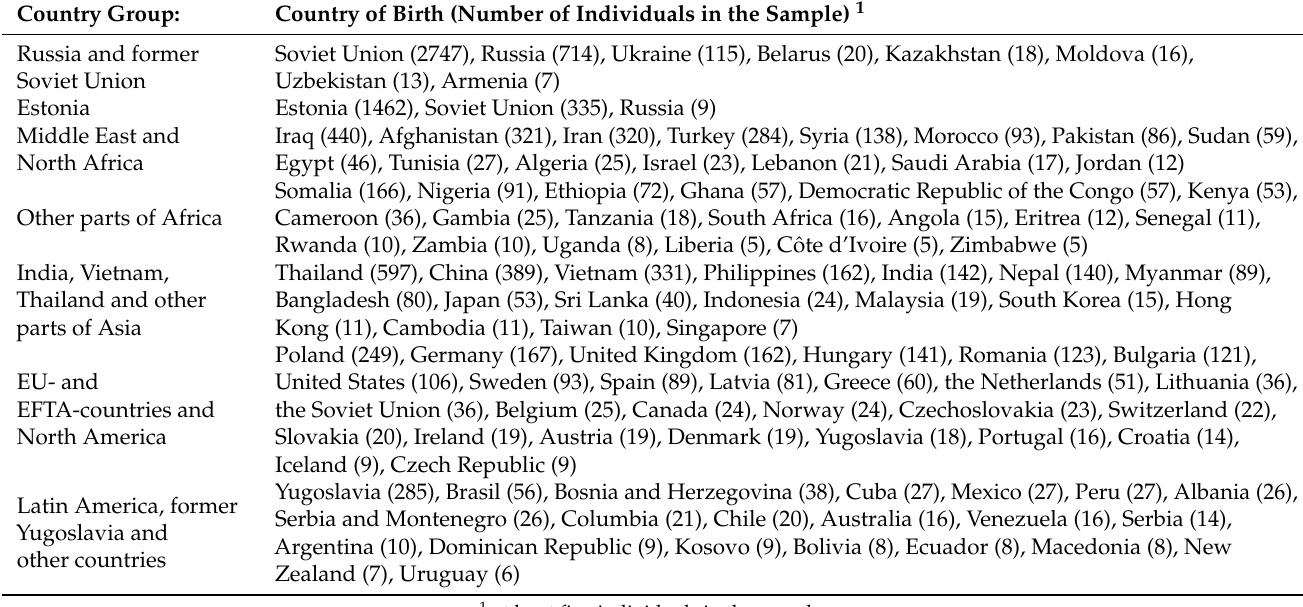
Table 4. Most common countries of birth according to the country